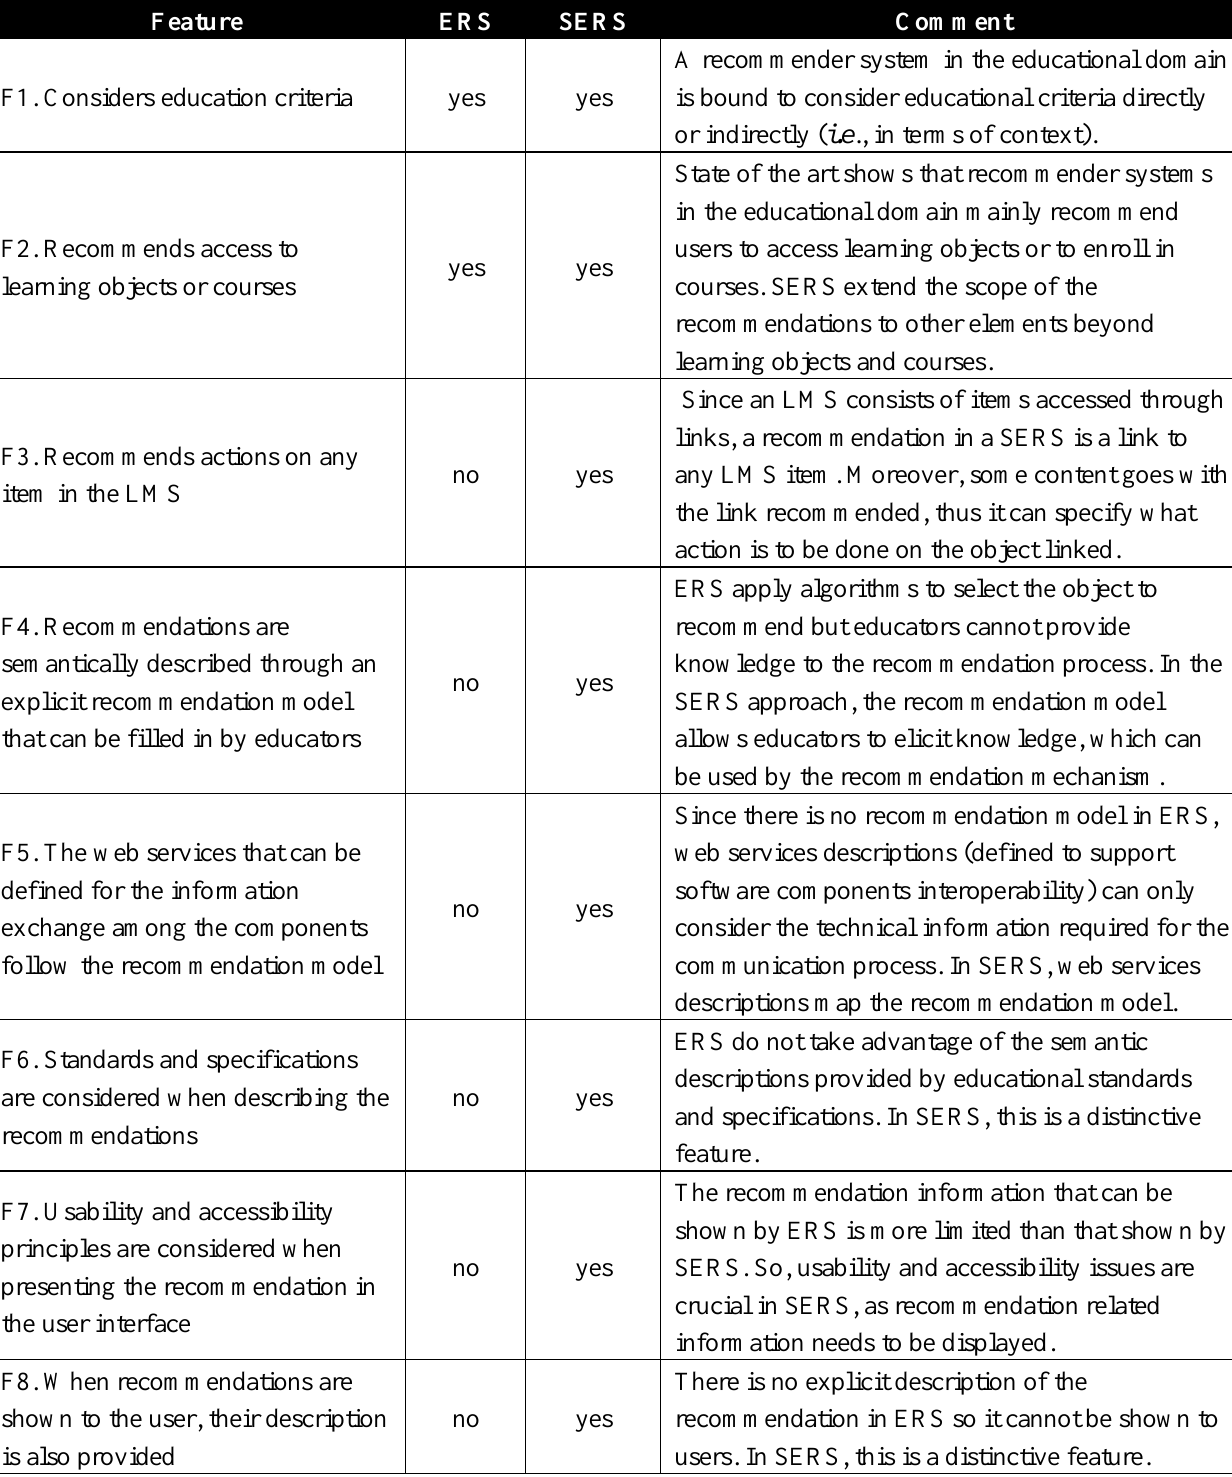
Table 2. Comparison between ERS and